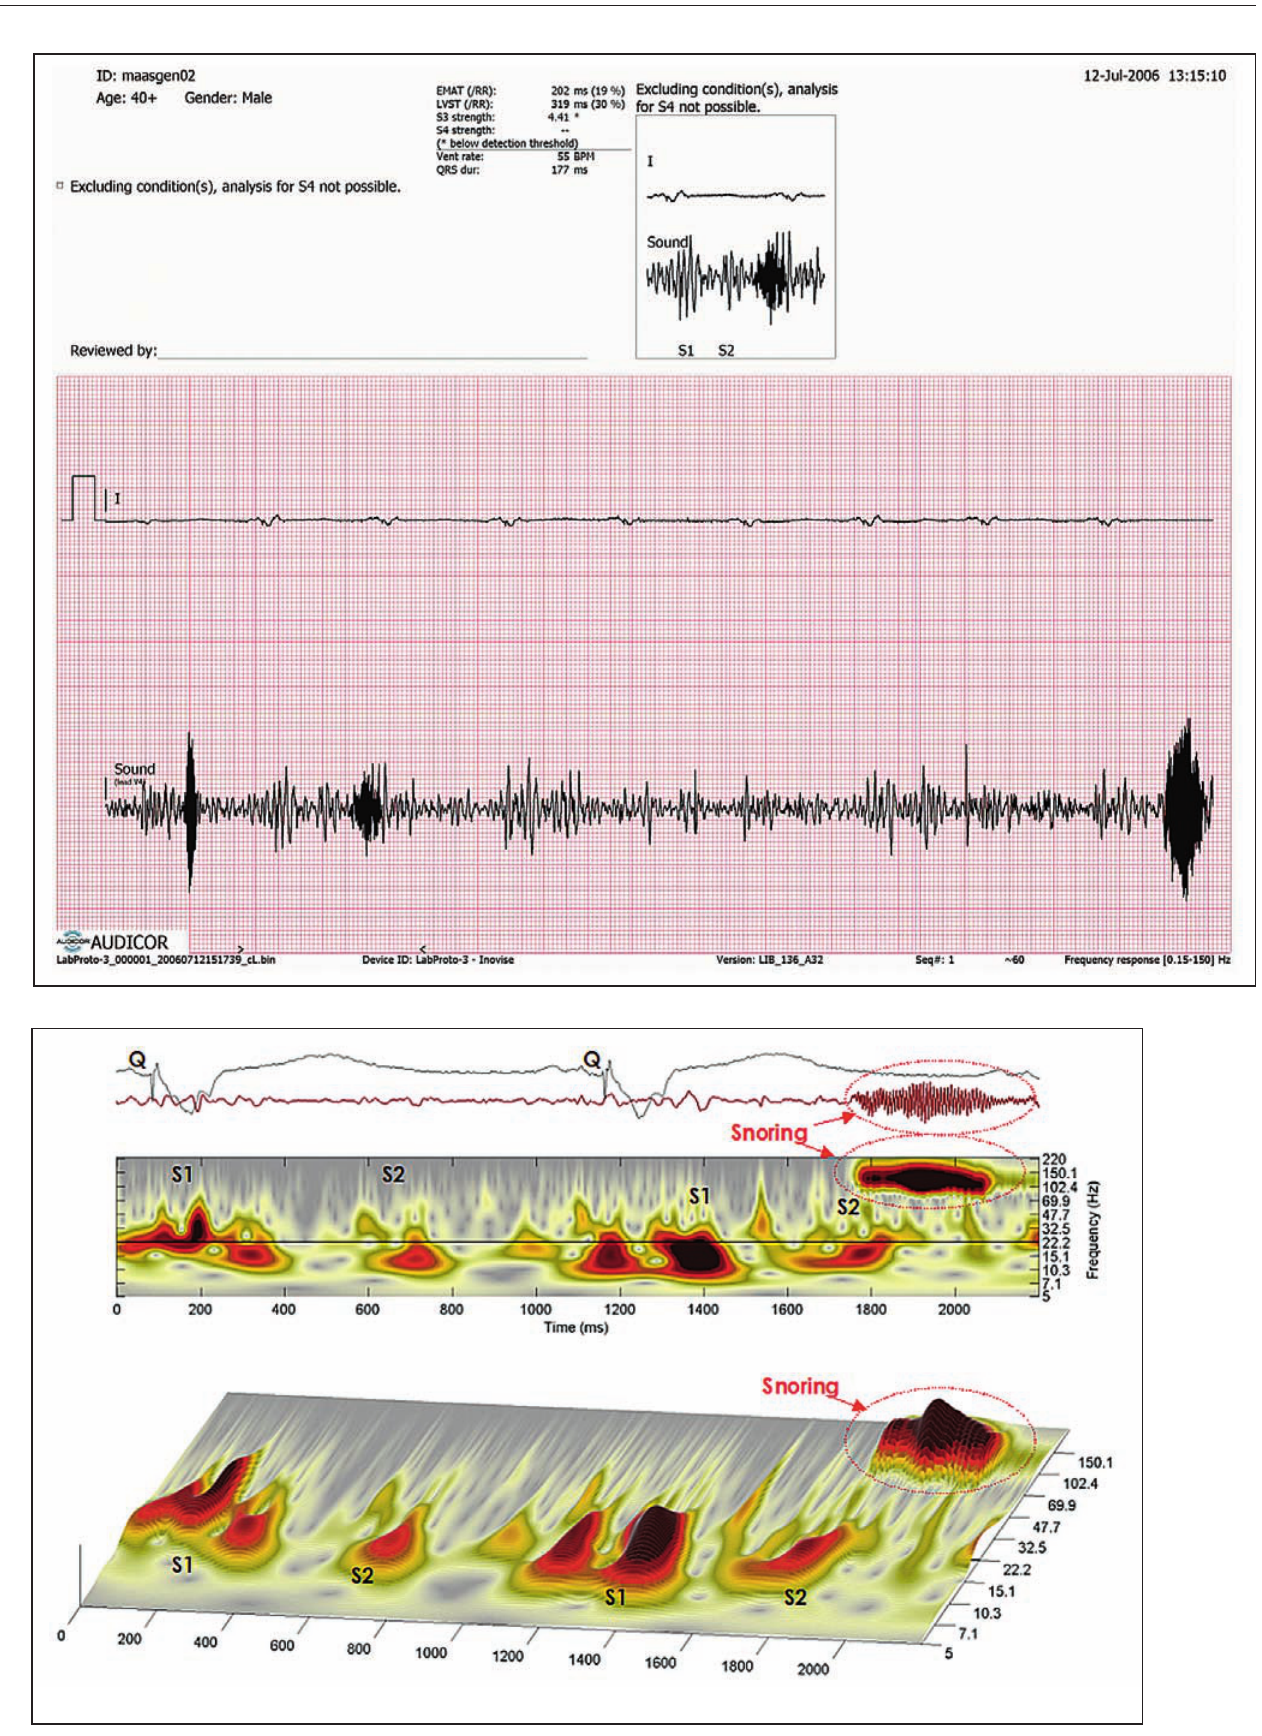
Figure 5 Acoustic cardiography report and time-frequency analysis of heart sounds for a subject with episodes of snoring. The upper panel (a) shows an acoustic cardiography report for a subject with episodes of snoring, and the panels below (b) illustrate the 2D and 3D scalogram views for two beats from the acoustic cardiography rhythm strip shown above. The “fingerprint” of the snoring as well as other pulmonary sounds is very different from the heart sounds in the scalogram view, and while it is hard to verify in the time domain view, the algorithm can easily filter out those